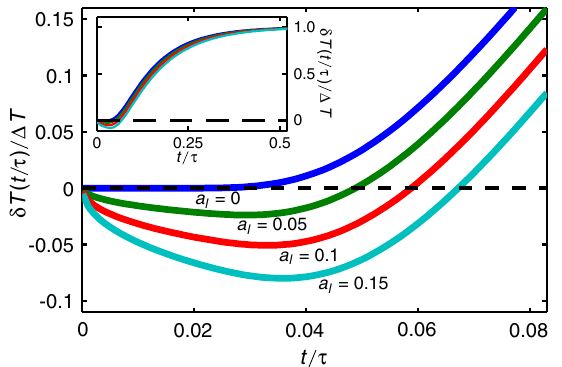
FIG. 6. The temperature at the center of the sphere as a function of time. After the temperature at the surface is raised, the temperature at the center of the sphere initially decreases. (cid:1) c , i.e., when the longitudinal This only happens when c l p coupling a is not negligible. The temperature step at the l boundary is (cid:1) T ¼ 1 K , and the time scale is given by the =(cid:8) . characteristic diffusion time, (cid:1) ¼ R 2 c l